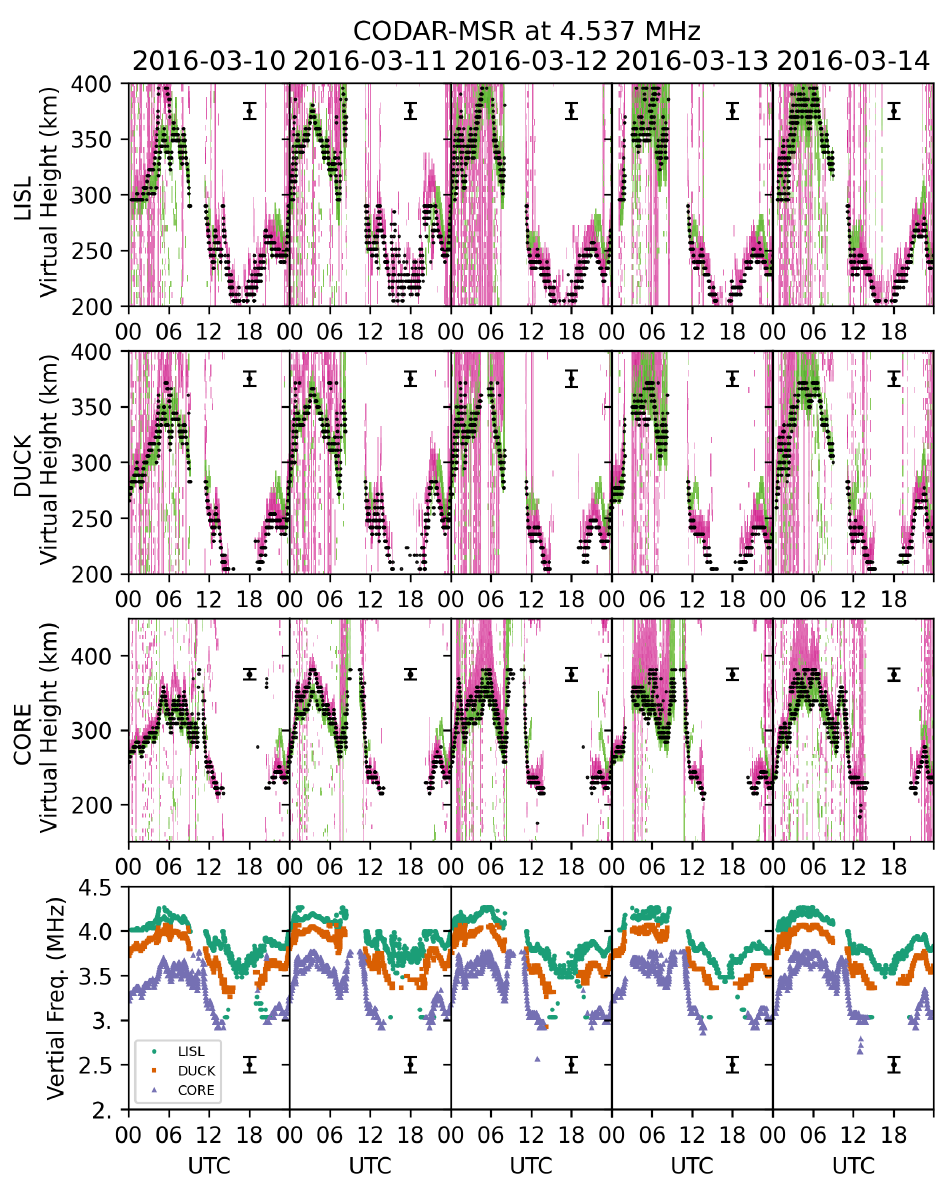
Figure 5. A comparison of the virtual heights derived using the CODAR observations from MSR for 10–14 March 2016 and the virtual height from the WP937 digisonde at Wallops Island, VA. The figure is in the same format as Fig. 4, except there is no distinction between the X and O mode for the CODAR observations. See the text for more